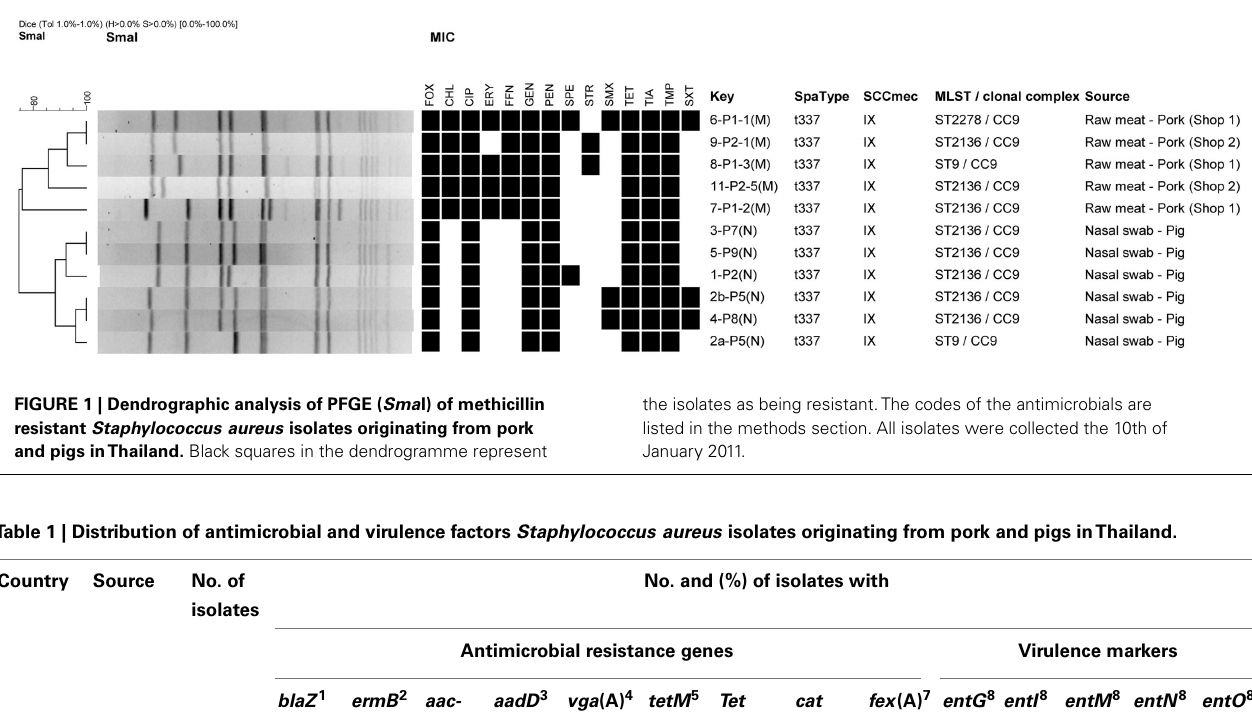
No. and (%) of isolates